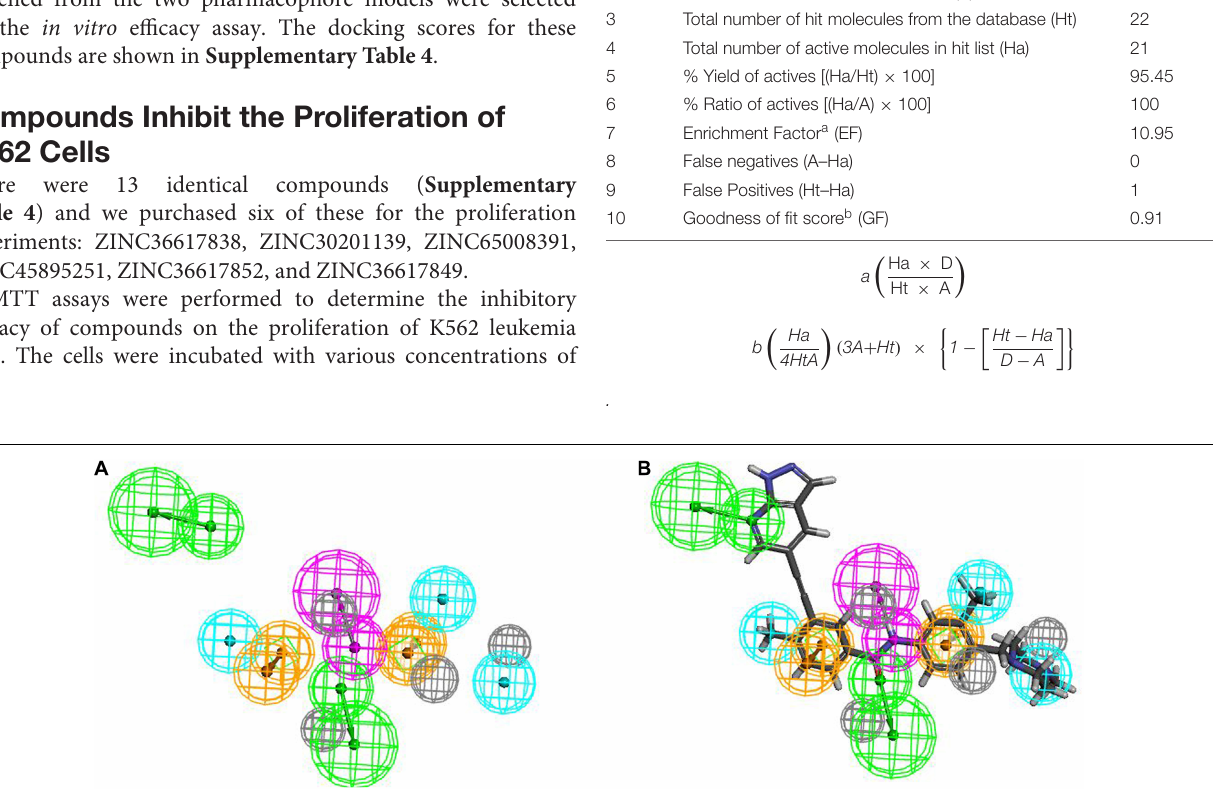
Frontiers in Cell and Developmental Biology |